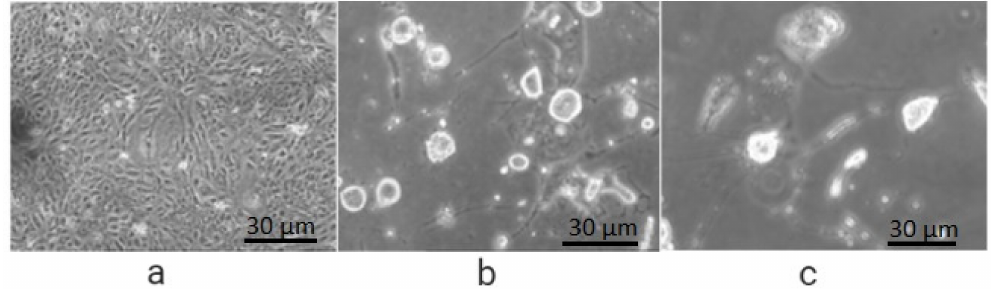
Figure 3. Cellular uptake efficiency in FR HeLa cells after 48 h of incubation: ( a ) with solvent (PBS) showing full growth; ( b ) treated with 5-FU, reduced growth; ( c ) treated with FA-PEG-5-FU showing less growth than